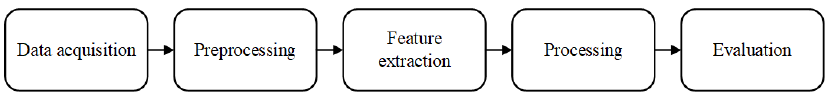
Figure 2. General architecture of Fall Detection Systems.